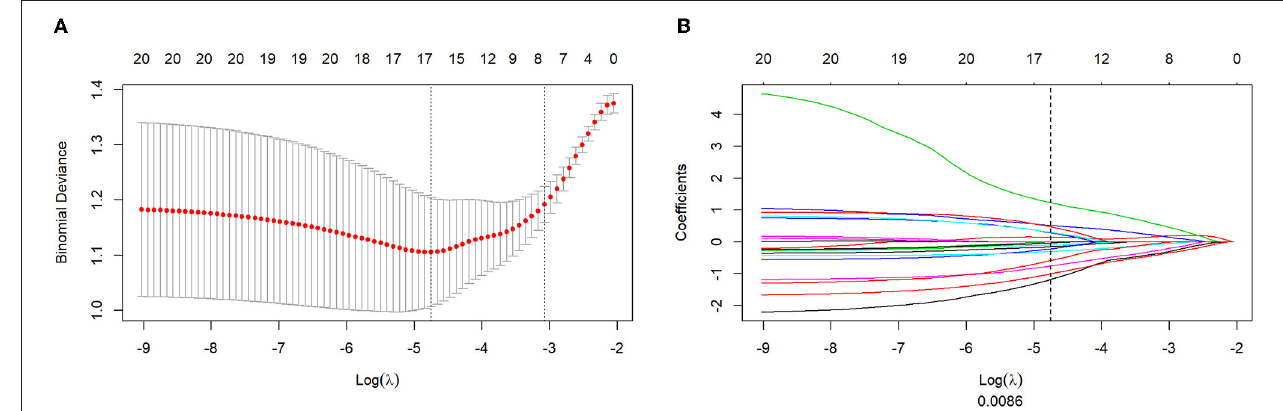
FIGURE 2 | Texture feature selection using the absolute shrinkage and selection operator (LASSO) binary logistic regression model. (A) The penalty term ( λ ) in the LASSO model was selected through 10-fold cross-validation which is based on minimum criteria. Y-axis means binomial deviances. Down-X-axis means the log ( λ ), Up-X-axis means the average number of predictors. The red dots indicate average deviance values for each λ that different models have different deviance. Left-vertical-line shows the lowest deviance that the model showed the best fit to our training group. (B) LASSO coefficient profiles of the 16 features. The dotted vertical line was drawn at the value where log λ (0.008) resulted in eight non-zero coefficients.